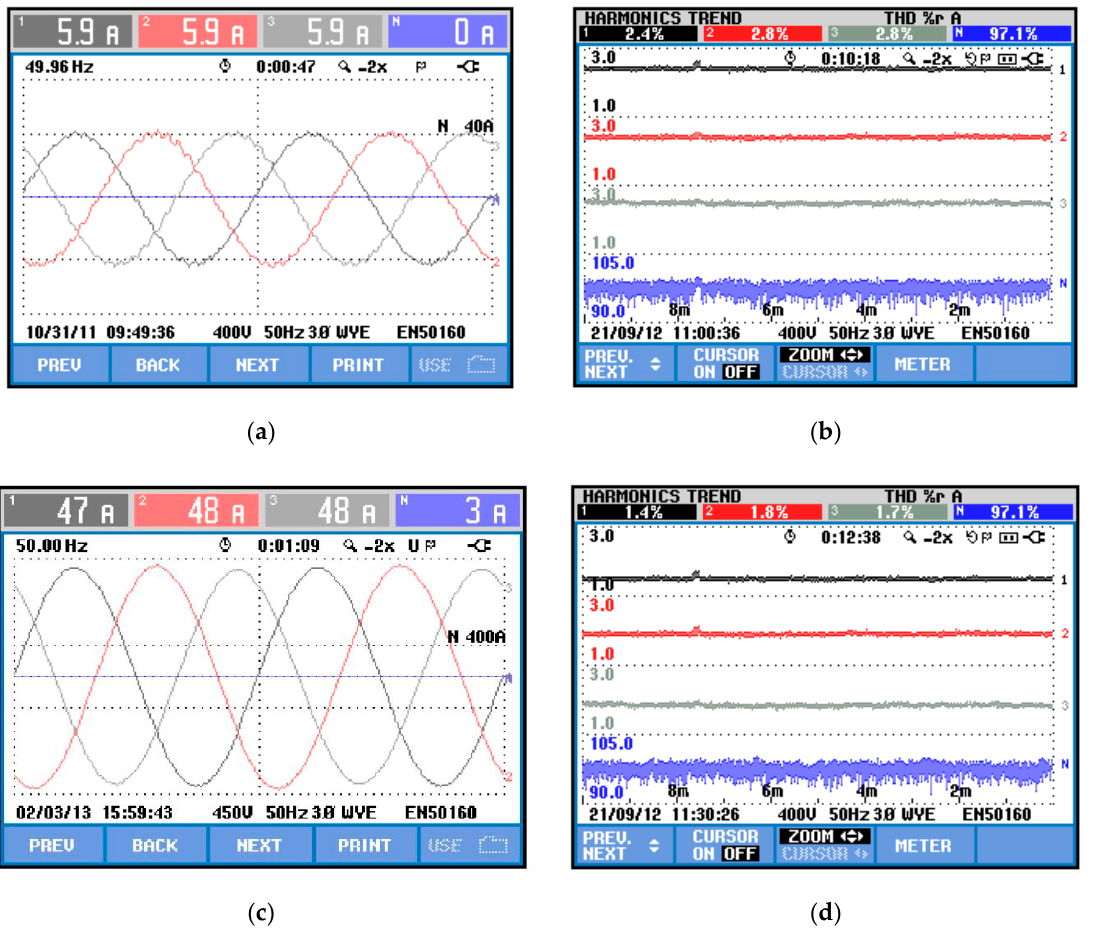
Figure 17. Current output waveforms and THD trend of PCS: ( a ) Current output waveforms of PCS (100 kW); ( b ) THD trend of PCS (100 kW); ( c ) current output waveforms of PCS (800 kW); ( d ) THD trend of PCS (800 kW).